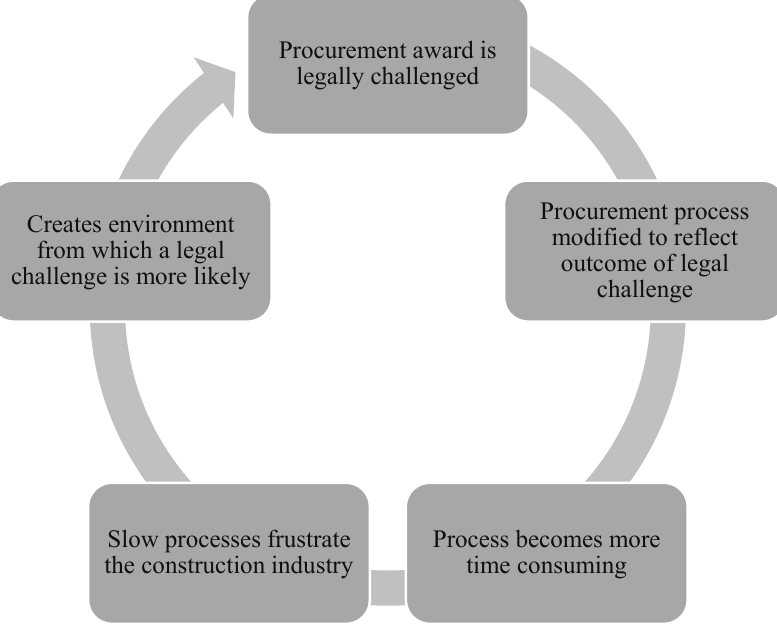
Figure 12. Vicious circle created by legal challenges.